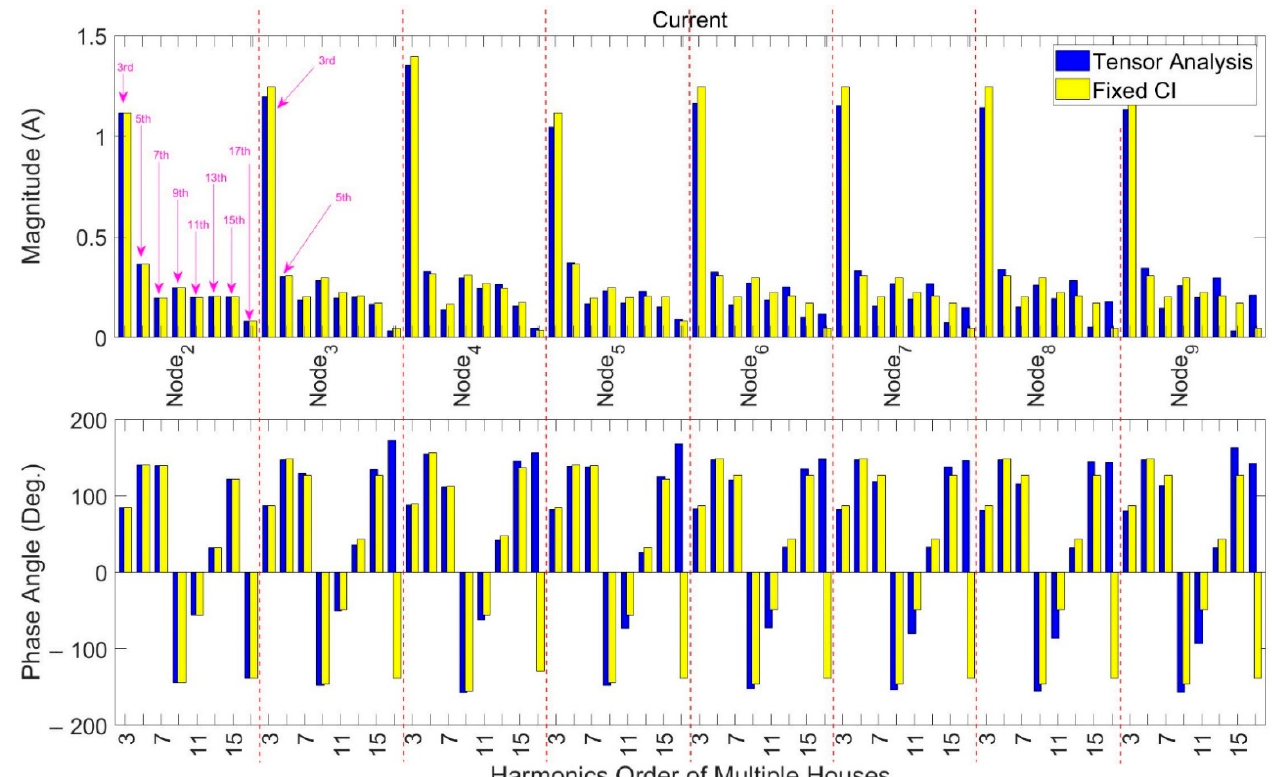
Figure 13. Comparison for nodes 2–9 (90% nonlinear devices).